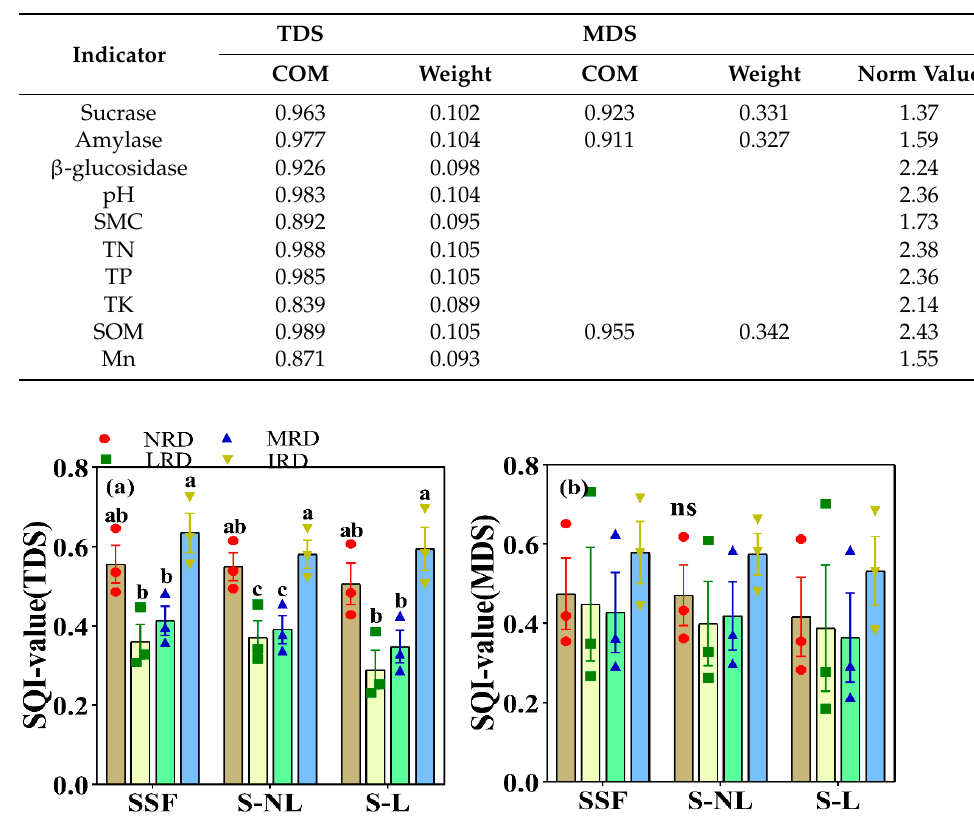
Table 4. Communalities, weight and norm value of environmental factors based on minimum dataset (MDS) and total dataset (TDS), respectively. COM: communalities.